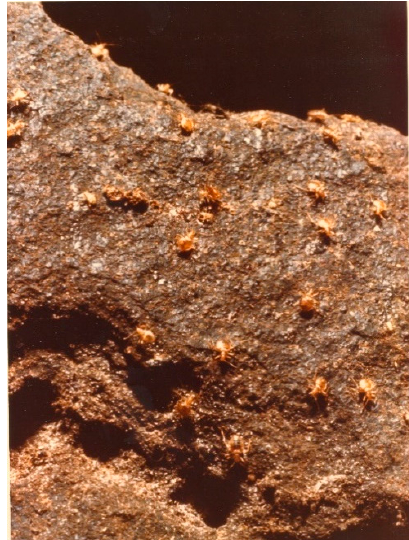
Figure 5. Cimicid bugs on the cave wall, Kaeng Khoi cave. A flea perched on top of a bug is also present mid-way down the center of this photo. Photo by W.A. Neill. Table 3. Amount of virus in pools of three cimicid bugs at different times after an infectious blood meal with